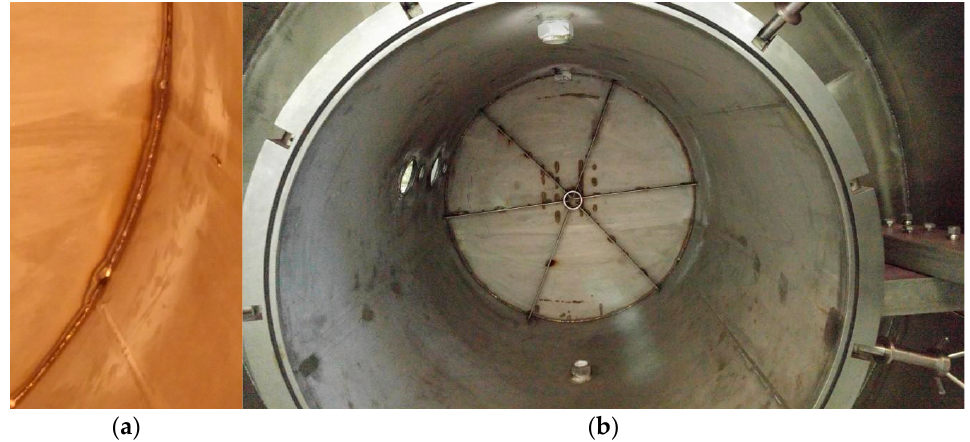
Figure 5. The tightness improvement of the radon chamber (the continuous argon welding): ( a ) inner welding (detail) of the bottom steel plate of the radon chamber; ( b ) general view inside the radon chamber, with the “star” steel piece and the 6 radial steel strips welded on the bottom plate.